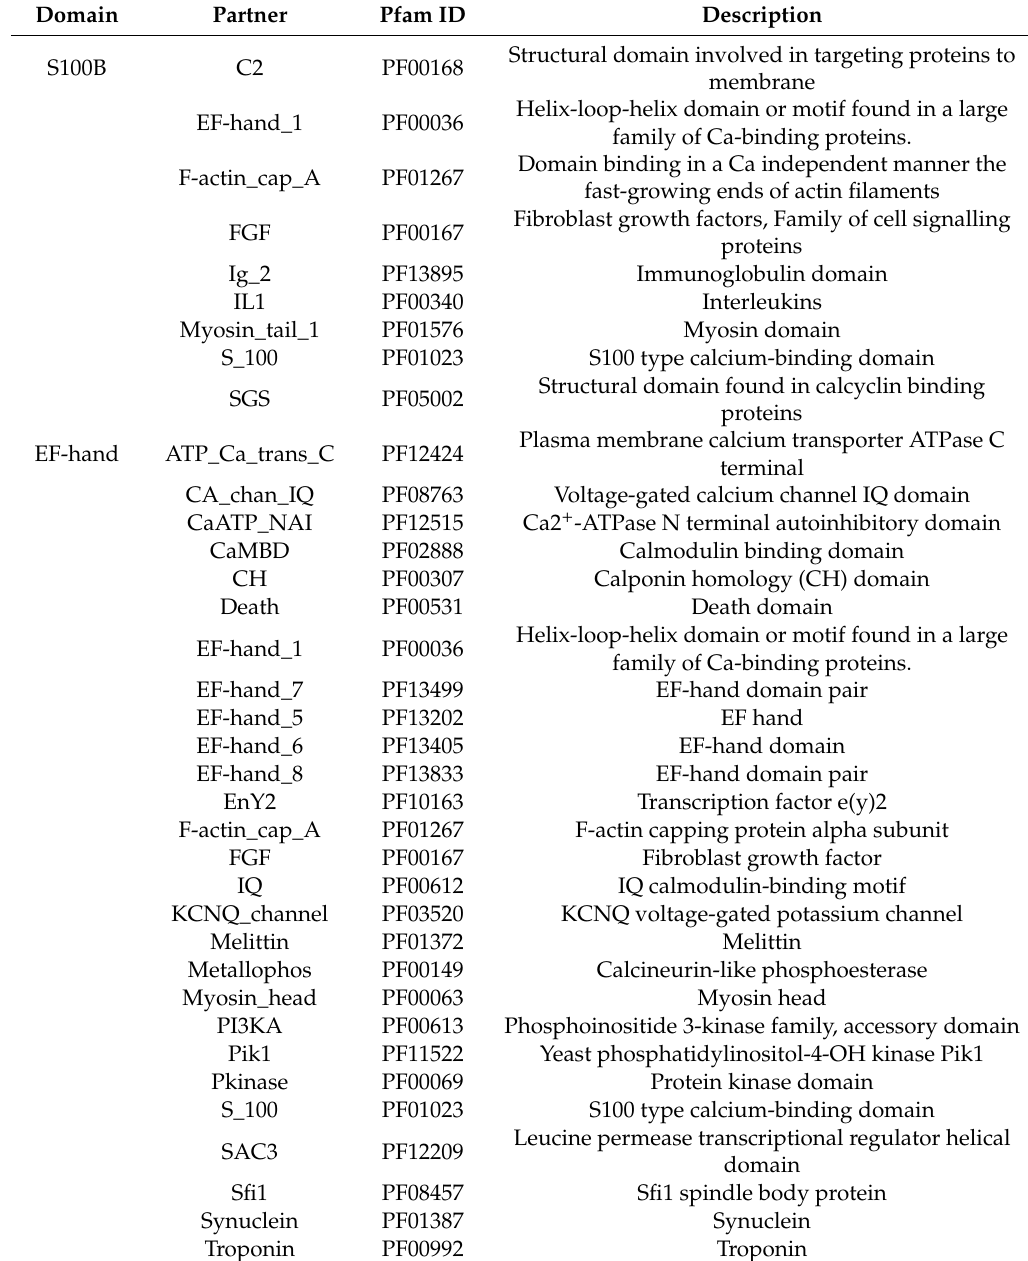
Table 1. S100B potentially interacting domains. The S100B protein is composed of two structural domains: the S100 and the EF-hand. The table reports the list of protein domains potentially interacting with both of them. Some domains (e.g., the FGF domain) are able to interact with both. The S100 domain is also able to interact with itself generating